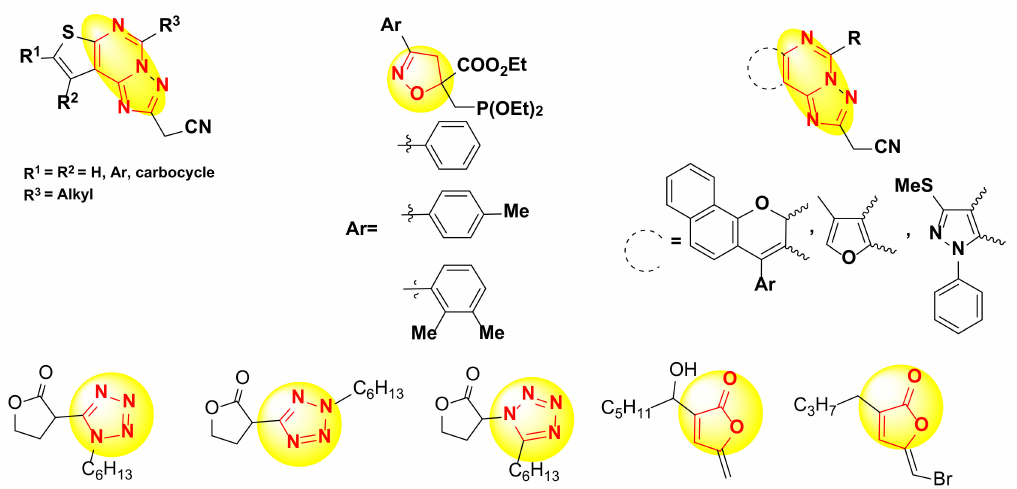
Figure 1. Several families of biologically relevant heterocyclic compounds, such as condensed pyrimidines, isoxazolines, pyrazolines, tetrazole, and furanone